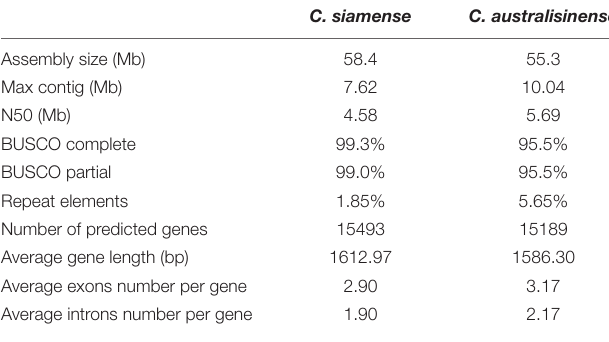
TABLE 1 | Assembly and gene prediction information of Colletotrichum spp.